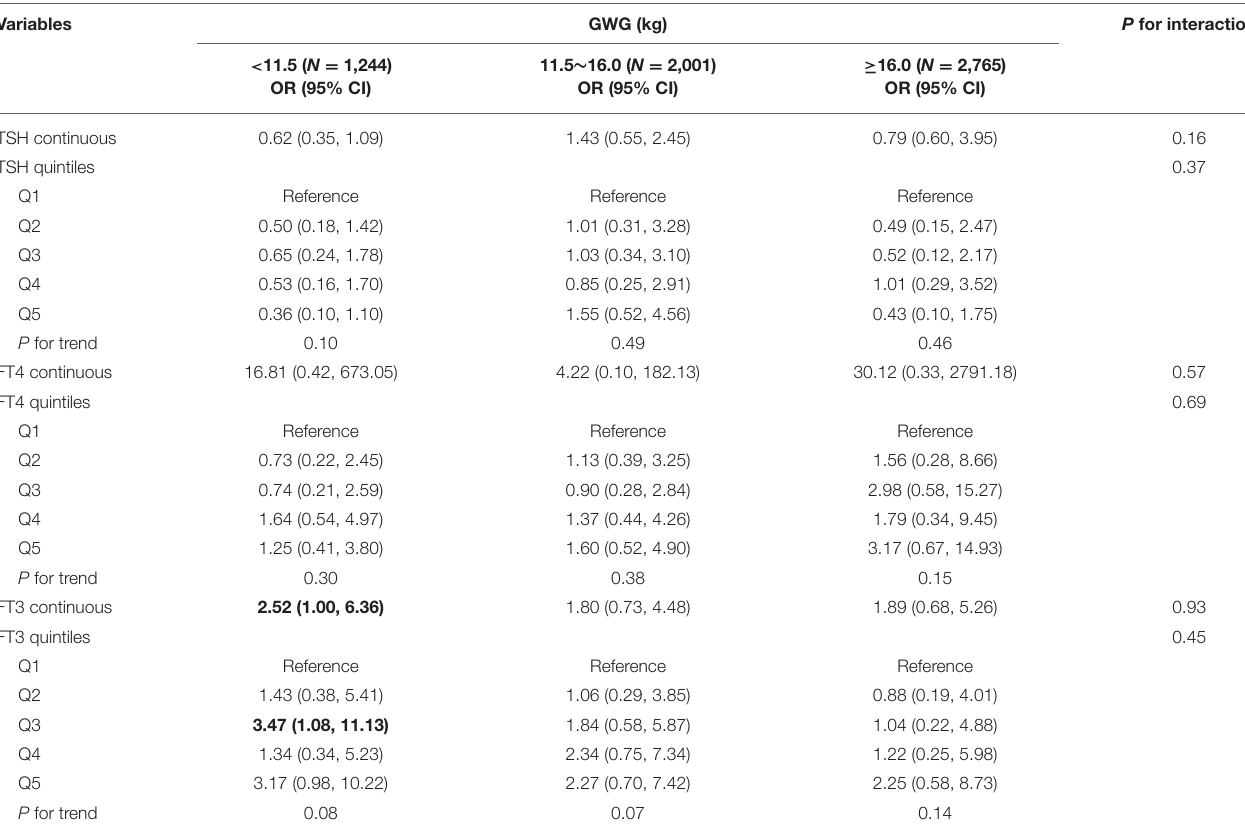
TABLE 4 | Adjusted OR a for low birth weight associated with maternal thyroid parameters during early pregnancy stratified by GWG among normal weight women ( N = 6,010).